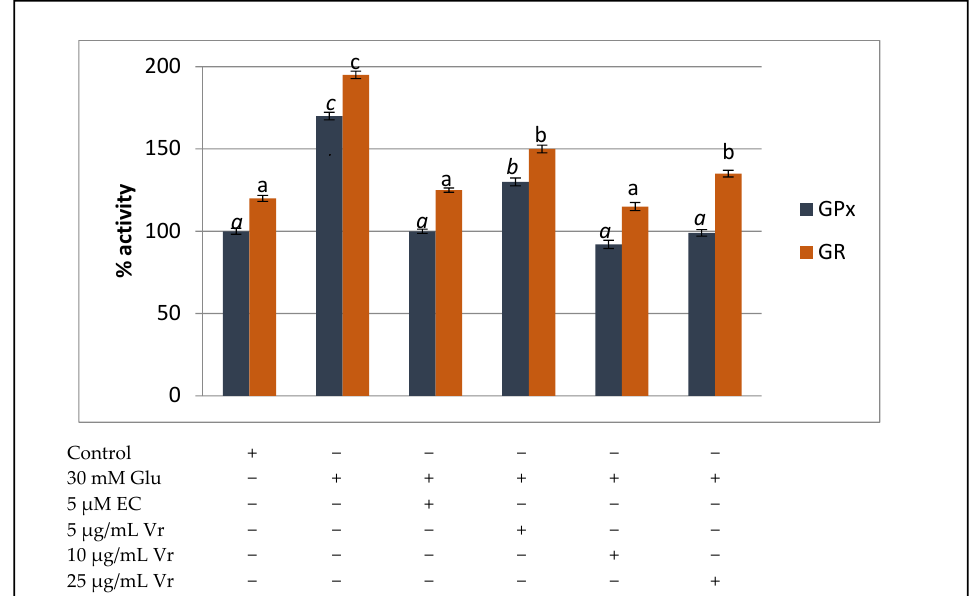
Figure 2. Protective effect of Vochysia rufa bark extract on GPx and GR activity of EA.hy926 cells treated with 30 mM glucose (Glu 30 mM) or 30 mM glucose plus noted concentrations of Vochysia rufa (Vr) extract or the positive control Epicatechin (EC). Values are means ± SD, n = 4. Values are expressed as a percent relative to activity of control condition. Different letters indicate statistically significant differences ( p < 0.05) among groups. Letters in italics correspond to statistical significance in GPx.